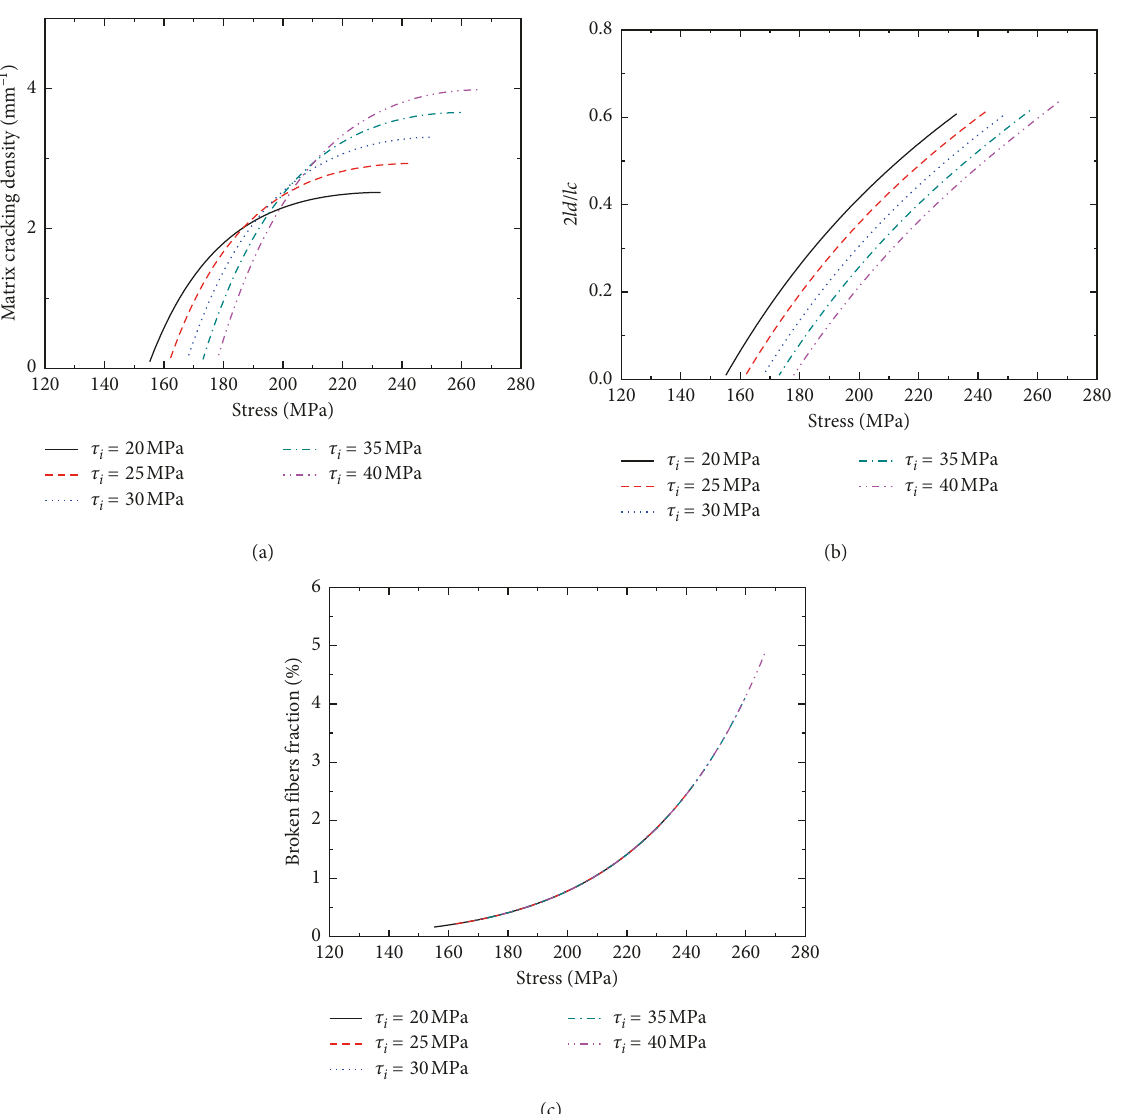
Figure 3: (a) The matrix cracking density versus the applied stress curves; (b) the interface debonding length versus the applied stress curves; (c) the broken fibers fraction versus the applied stress curves for different interface shear